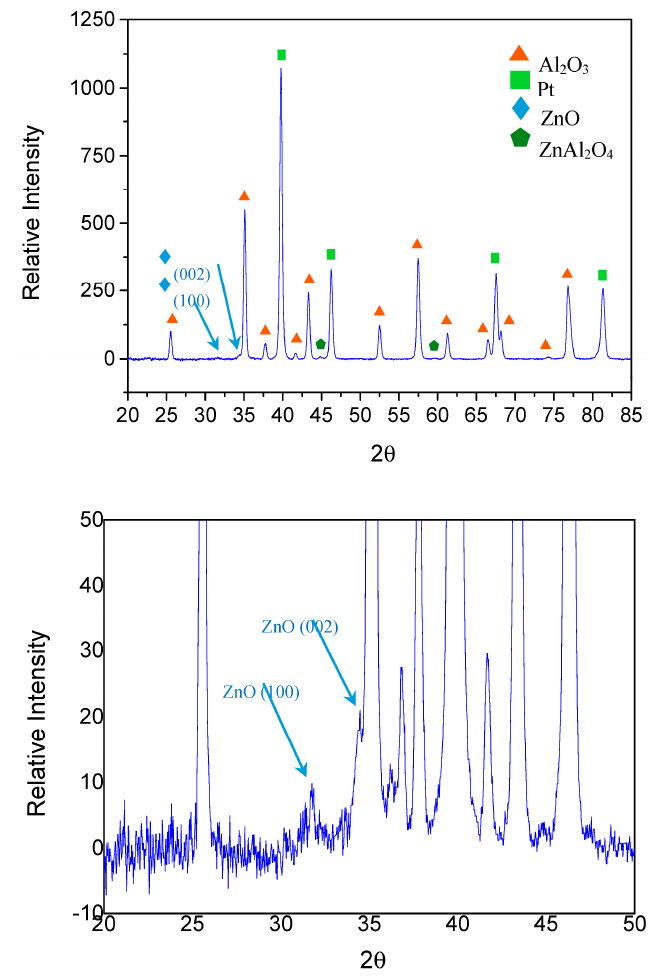
Figure 4. XRD analysis for sample 600HS1. The upper panel shows that the high-intensity peaks correspond to the electrodes and alumina substrate of the sensor transducer. The lower panel is an enlargement to better show peaks that correspond to hexagonal zinc oxide.